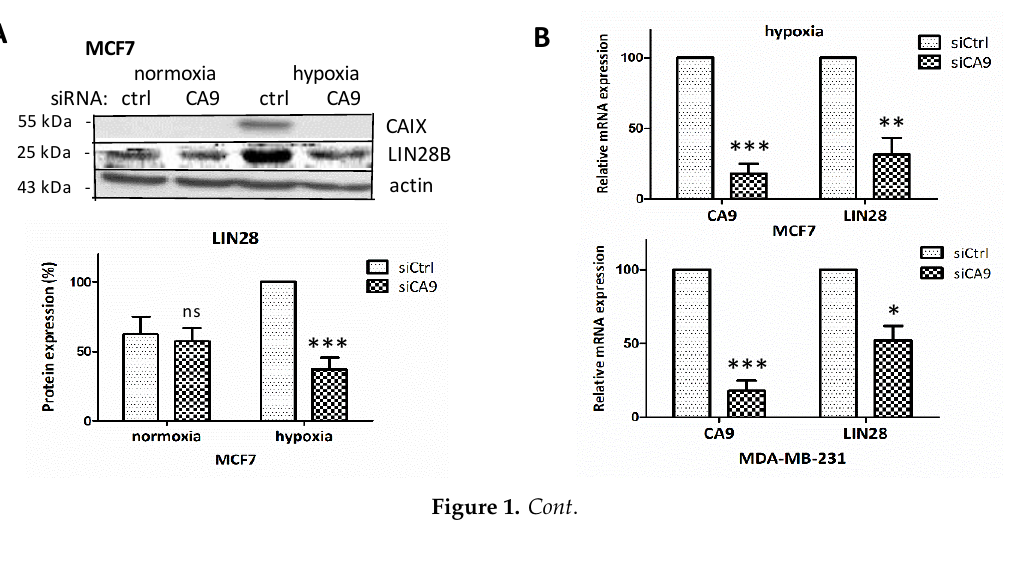
Figure 1. CAIX suppression affects LIN28 expression. ( A ) Representative Western blot of normoxic and hypoxic MCF7 cells transiently transfected with siRNA-control/siRNA-CA9, detecting CAIX, actin, and LIN28. Signal intensities from three different immunoblots were quantified using the ImageJ software, normalized to actin, and presented as an average percentage of hypoxic control- siRNA (=100%). ( B ) Quantitative PCR analysis of CA9 and LIN28 mRNA expression in hypoxic CA9 - silenced cells normalized to actin, presented as a percentage of the expression in cells transfected with